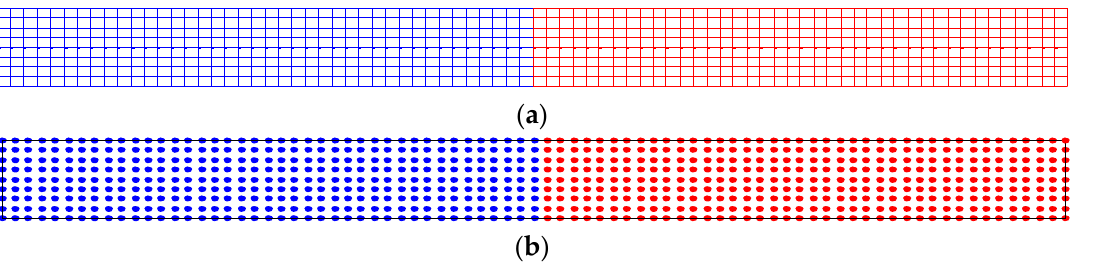
Figure 6. The used spatial discretization of the two-dimensional tube for different methods: ( a ) FEM- Q4; ( b ) RPIM.